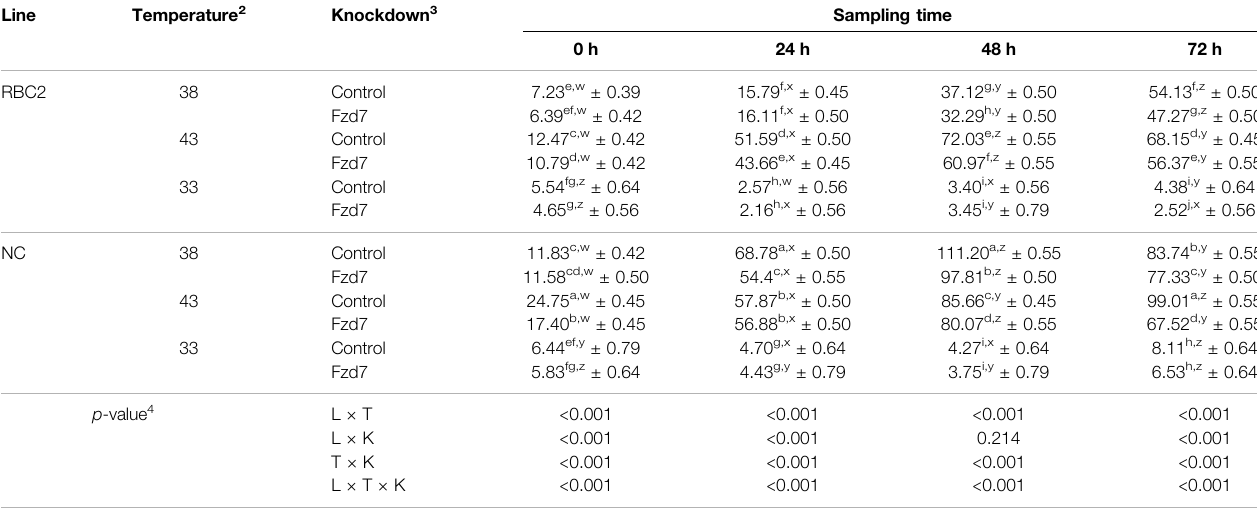
TABLE 4 | Effect of temperature and knockdown of frizzled-7 ( Fzd7 ) at the beginning of differentiation on differentiation of randombred control line 2 (RBC2) and modern commercial line (NC) satellite cells 1 .